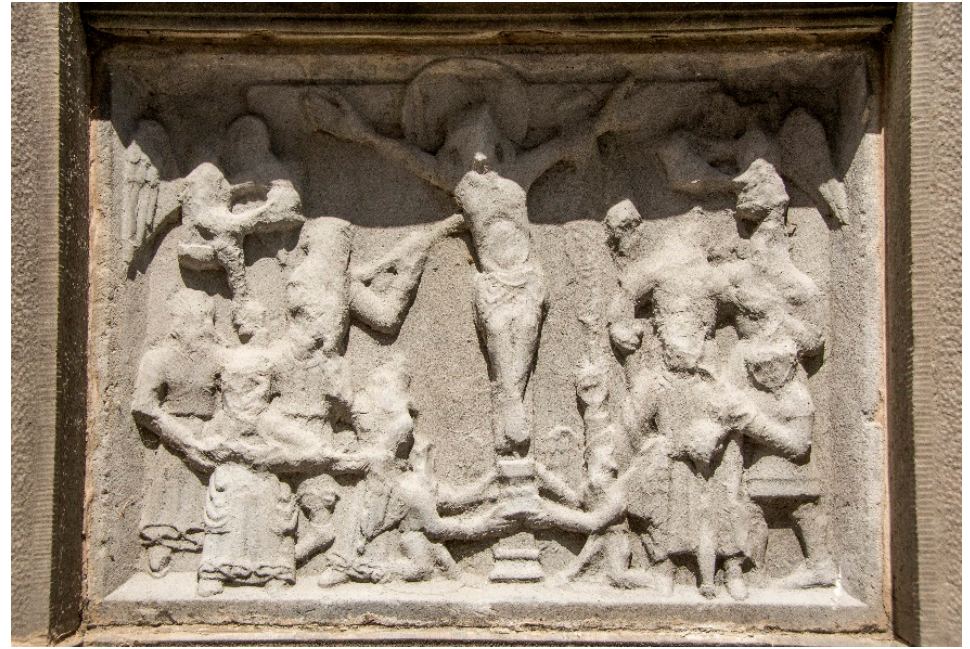
Figure 24. Creagh Tomb, Ennis Friary, Co. Clare, c.1470–1480 and reconstructed in c.1840s. Photo- graph by the author.